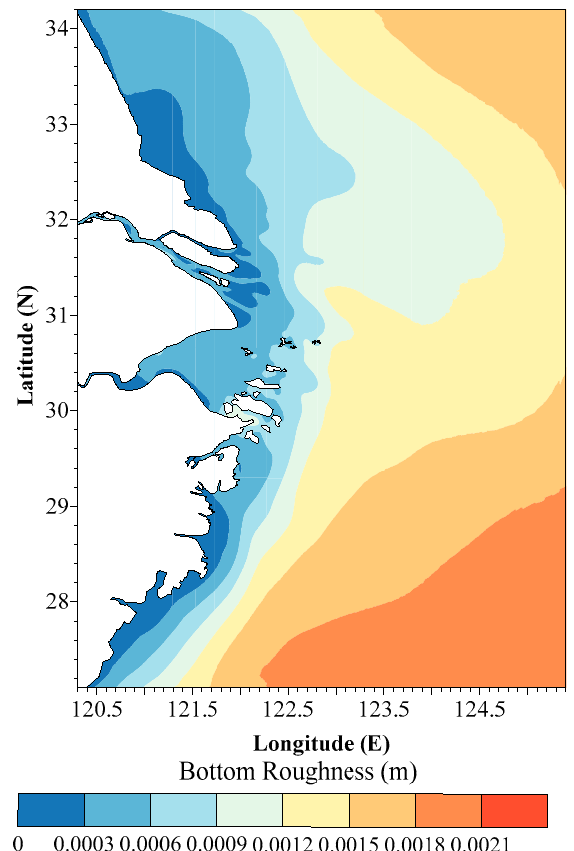
Figure 2. The bottom roughness ( k s ) of this model.